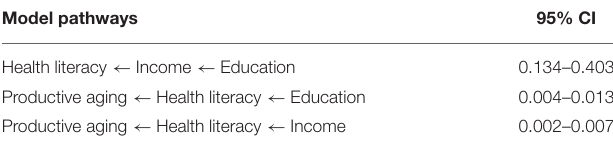
TABLE 6 | Significance test of every mediating